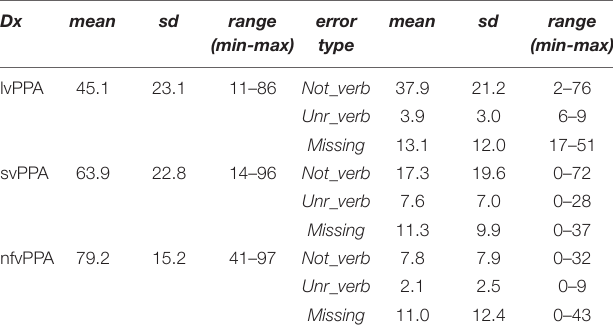
TABLE 3 | Behavioral performance across error types and PPA